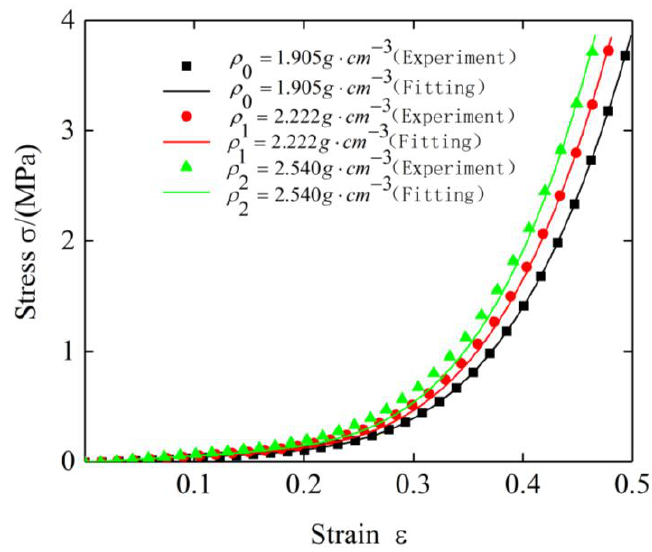
Figure 14. Stress – strain curves of plate-like EMWM with different densities and their fitting curves.